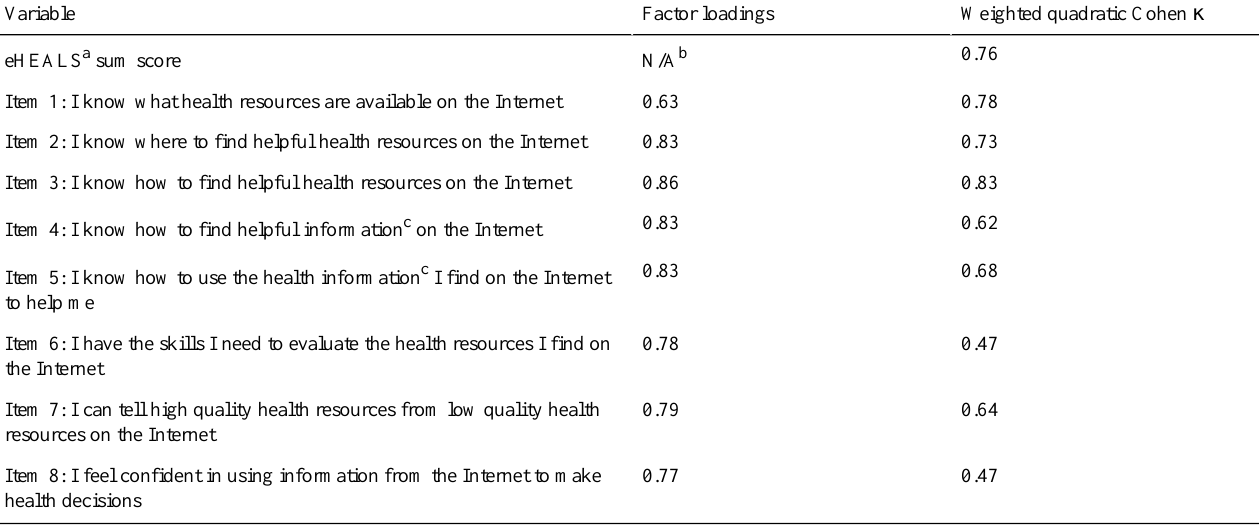
Table 4. Principal component analysis and weighted quadratic Cohen κ for the Arabic version of the eHealth Literacy Scale sum score or individual items.